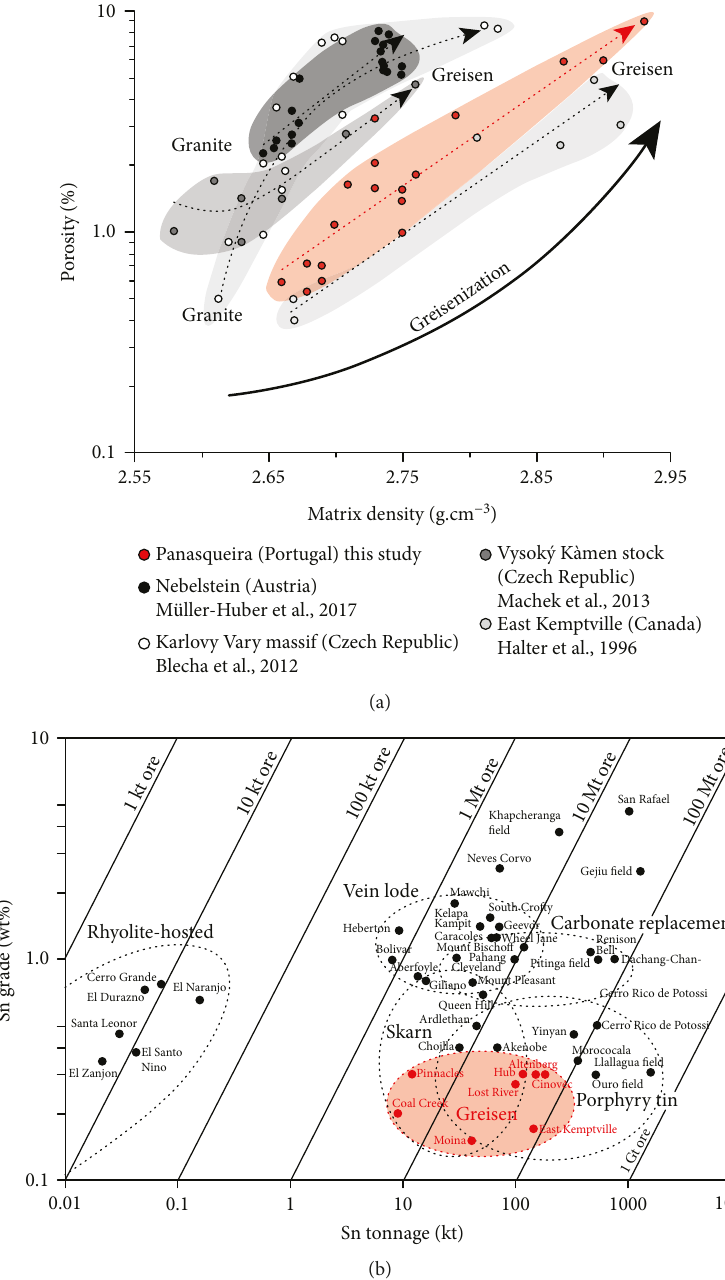
Figure 13: (a) Compilation of matrix density and porosity data measured in various granite-greisen systems. This compilation shows that increases in matrix density and porosity are common in greisen systems. It also suggests that feedback between greisen alteration and permeability may be a common process in this type of deposit. (b) Grade versus metal content for several types of large, high-grade, primary tin deposits (modi fi ed from [76]). Note that greisen systems can form high-tonnage, low-grade tin